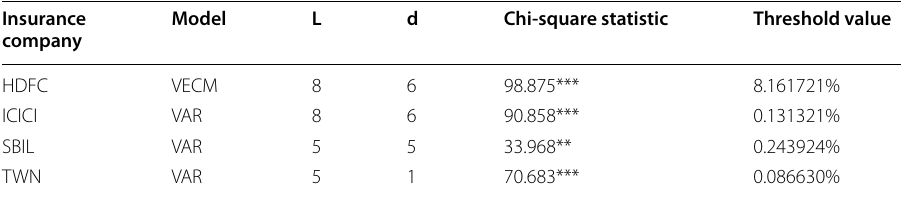
The notation "***" and "**" represent 1% and 5% significance levels, respectively; L represents the Lag periods, d represents the delay